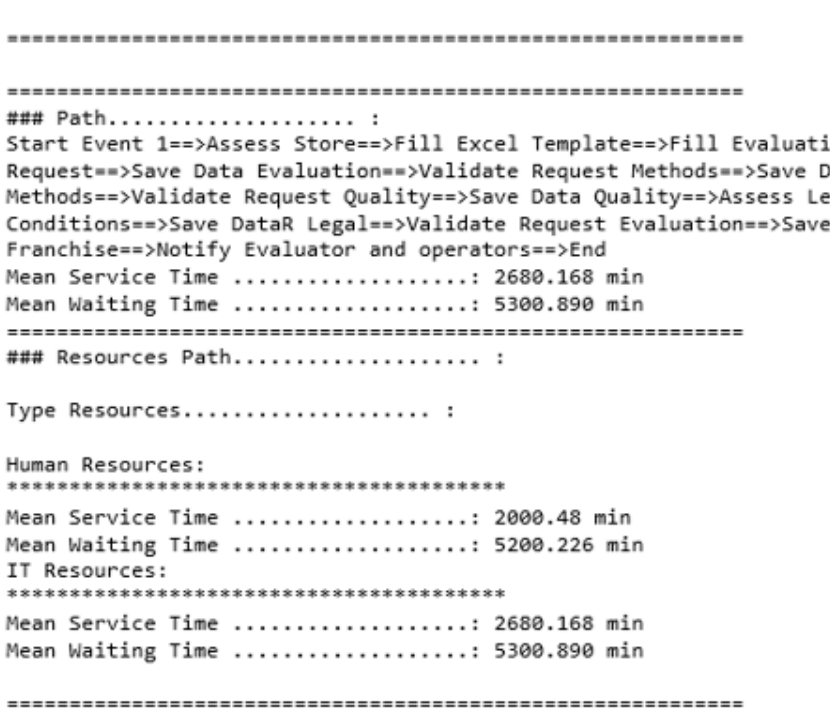
Figure 20. Global results of each type of resource for experienced human resources.